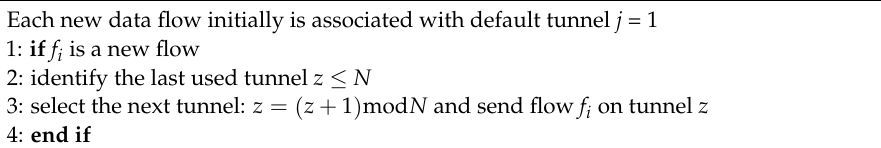
Algorithm 4 Round Robin Load-Balancing